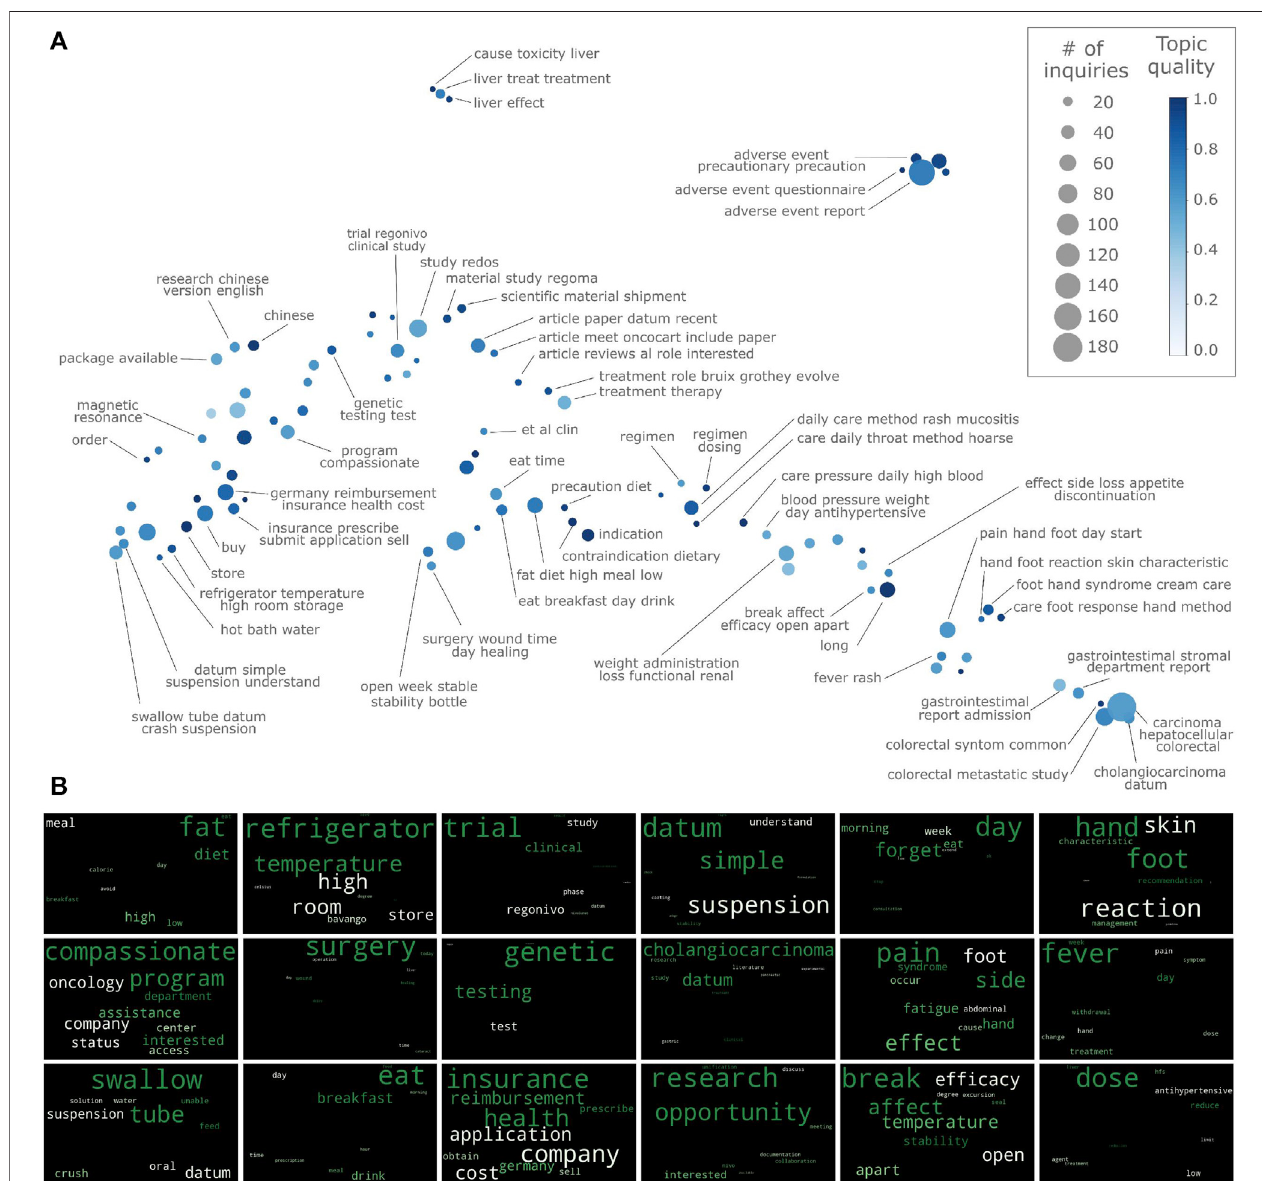
FIGURE 2 | Topic discovery for medical inquiries on regorafenib. (A) Topic semantic map. Axis are the non-linear dimensionality components and thus are not shown. (B) Wordclouds for selected topics.